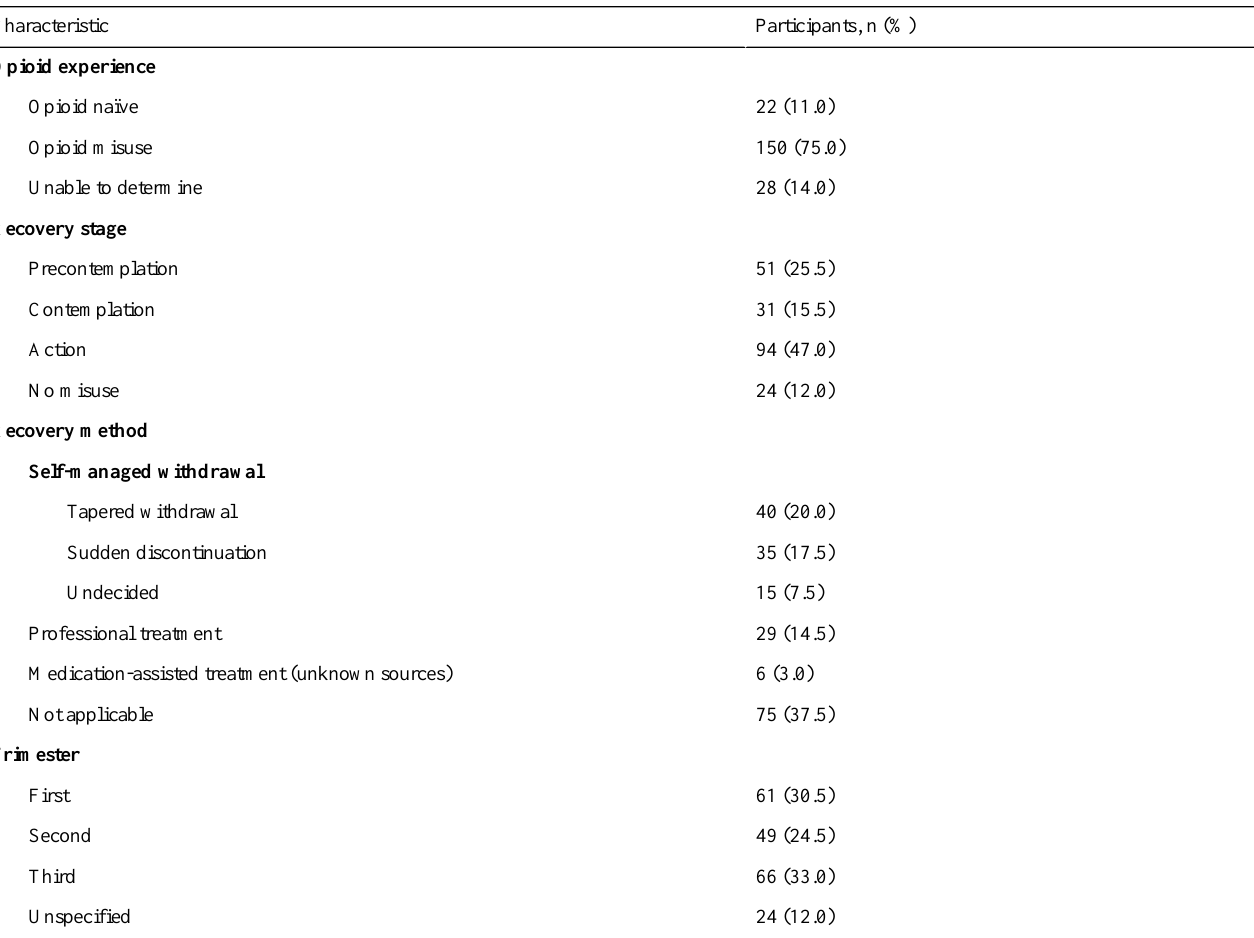
Table 2. Characteristics of women inquiring about opioid use in the online health communities